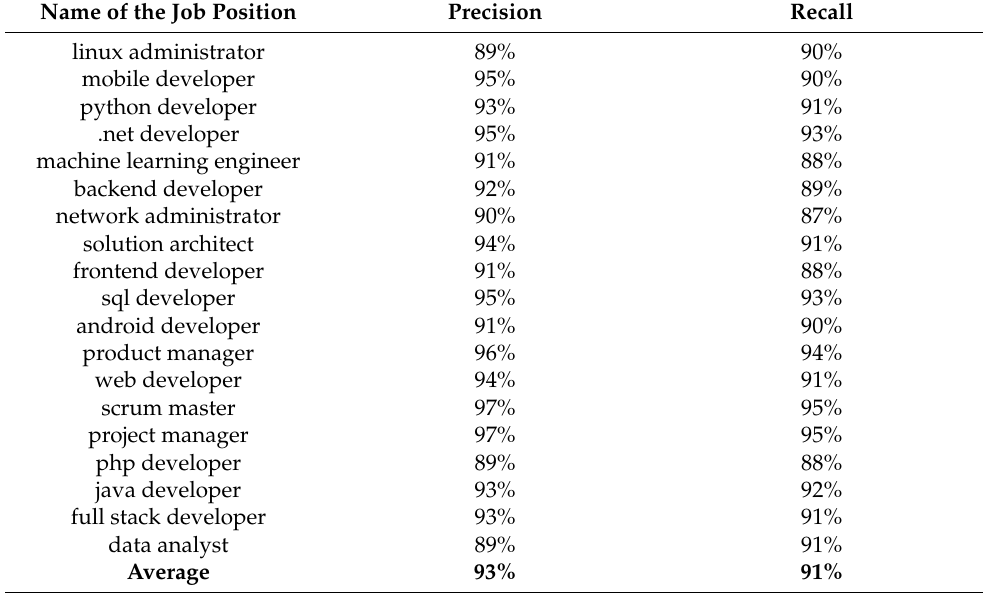
Table 10. The precision and recall metrics in a random sample of job advertisements. Name of the Job